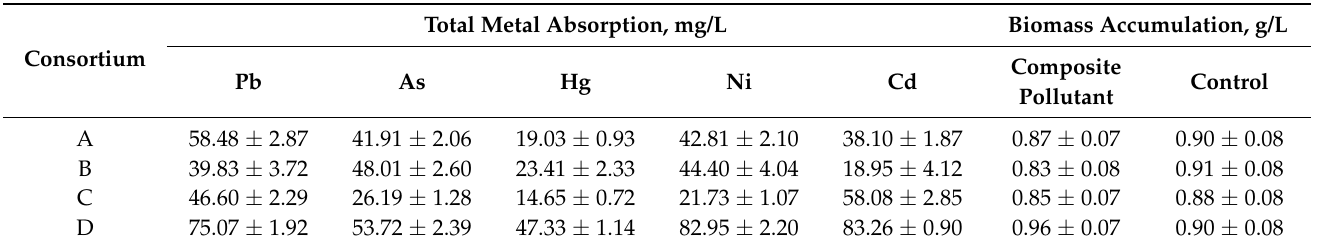
Table 8. Biomass accumulation and total absorption of mixture metals by various consortiums.